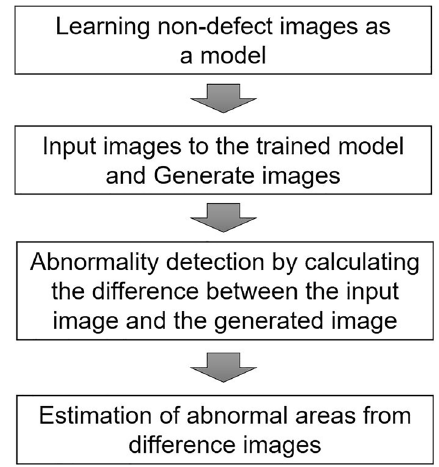
Fig. 2 Outline of proposed